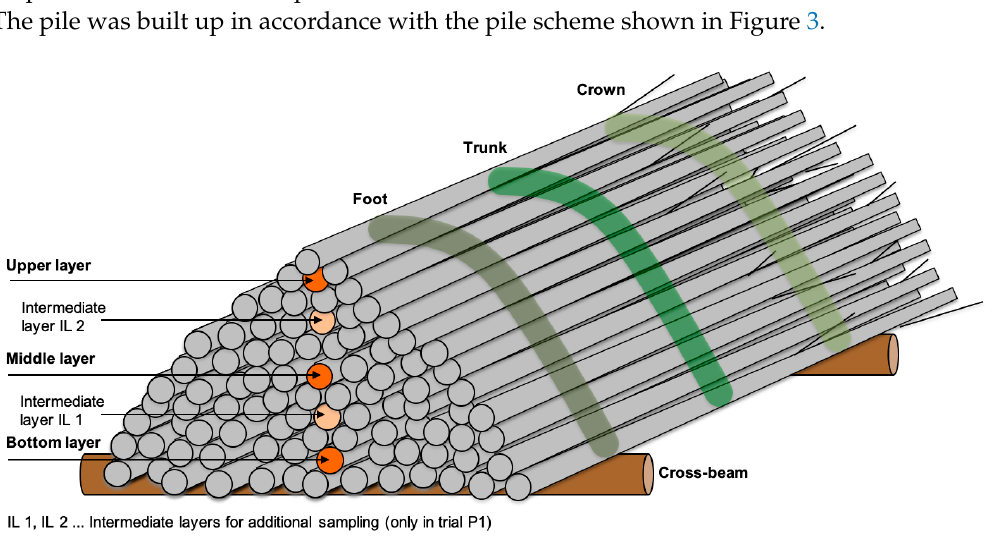
Figure 3. Schematic structure of the storage piles and the positions of the measuring levels.